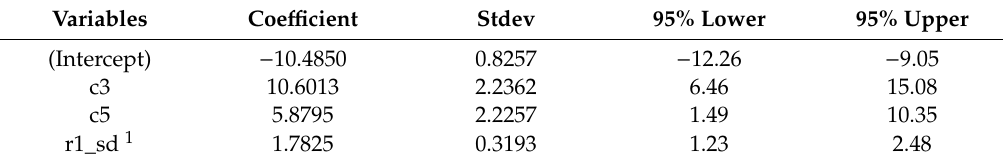
Table 3. GLMM Model 3 (2N × WAIC: 209.3).